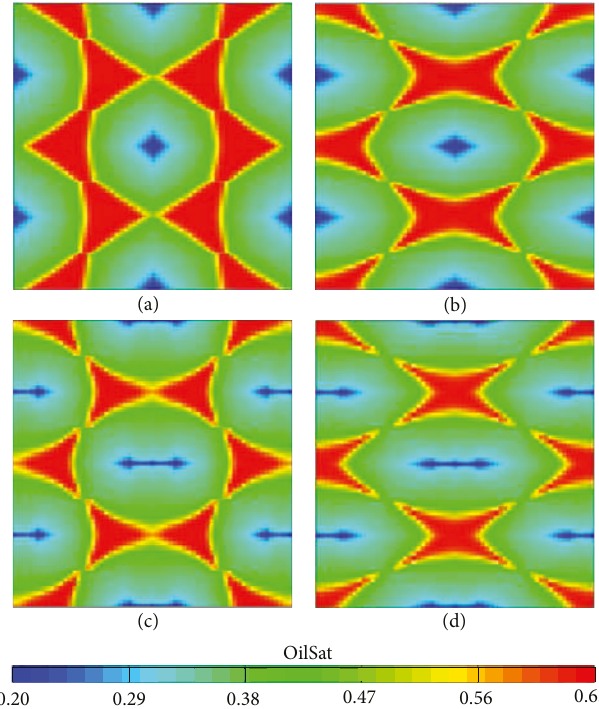
Figure 3: Plane distribution of remaining oil saturation at di ff erent k k : k =1:1 with no fractured injection well; (b) reservoir permeability k x y fractures and reservoir permeability k